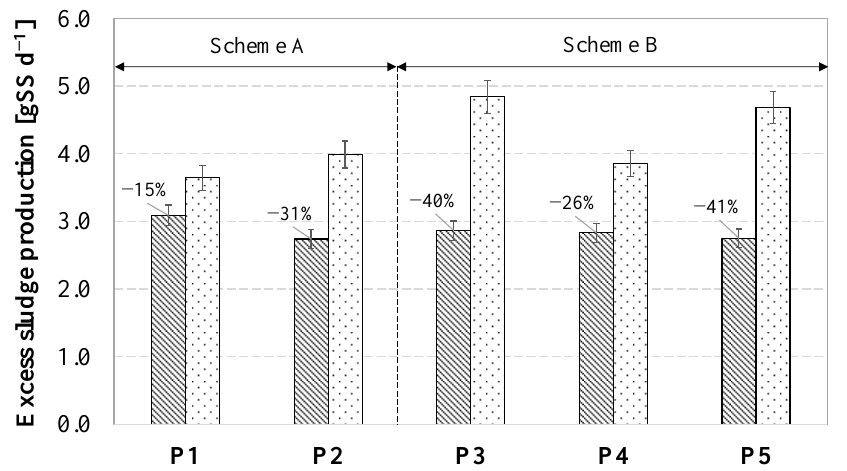
Figure 2. Excess sludge production in OSA and CAS plants during the experiment (bars indicate standard